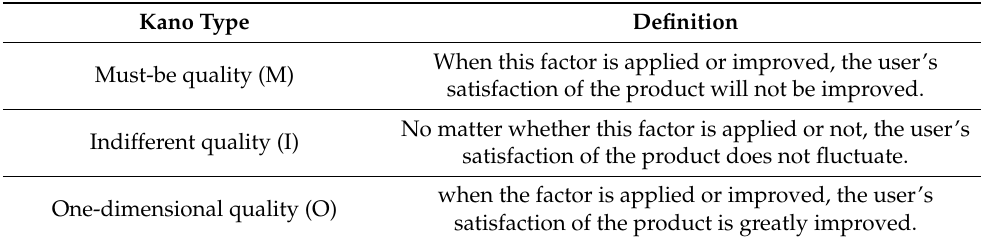
Table 2. Definitions of Kano types.